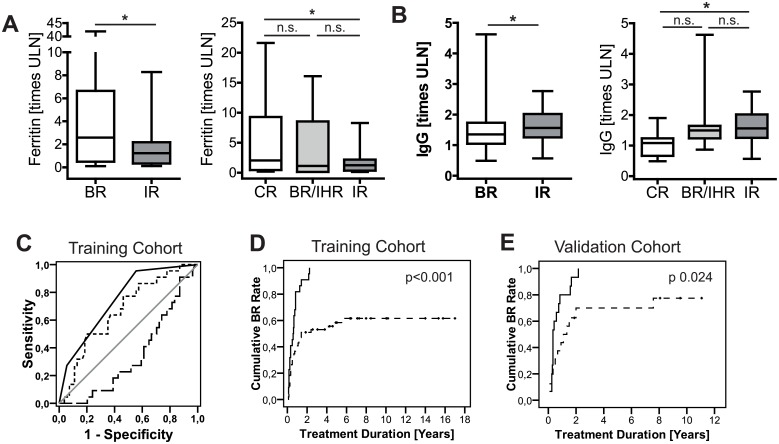
Hyperferritinemia and hypergammaglobulinemia were associated with the subsequent treatment response upon standard therapy in untreated AIH-1.(A) Left panel: Serum ferritin (SF) in untreated AIH-1 patients with subsequent biochemical remission (BR; N = 83) and incomplete biochemical response (IR; N = 26). Right panel: Histological treatment response with complete remission (CR: N = 16), BR with incomplete histological response (BR/IHR: N = 7) and IR (N = 26). (B) The same analysis for immunoglobulin G (IgG). (C) The AUROC analysis for the prediction of IR before the treatment initiation for SF (dashed line), IgG (dotted line) and their combined treatment response score (black solid line) in the retrospective trainings cohort (N = 76). (D) Rates of BR according to the treatment duration for the treatment response score<1 (solid line) and score≥1 (dashed line) for the training and (E) validation cohort. (* p<0.05; not significant, p≥0.05)